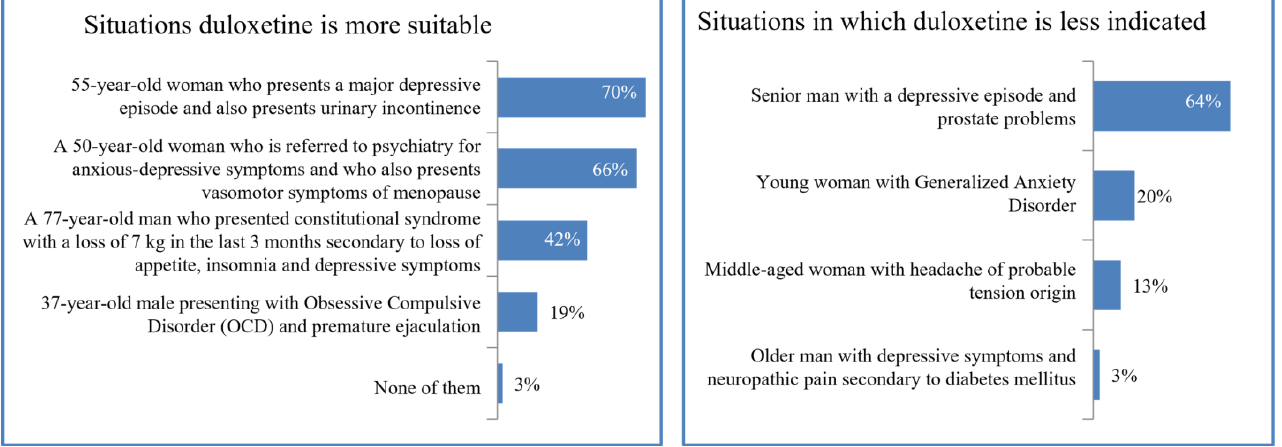
Figure 3. Situations for which duloxetine is the most and the least recommended antidepressant according to the doctors surveyed.